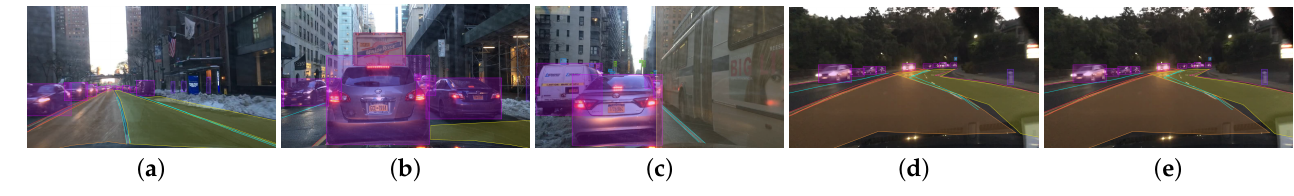
Figure 19. Visualization results of BUPT system on BDD100K data set. ( a – c ) are urban scenes, ( d , e ) are countryside